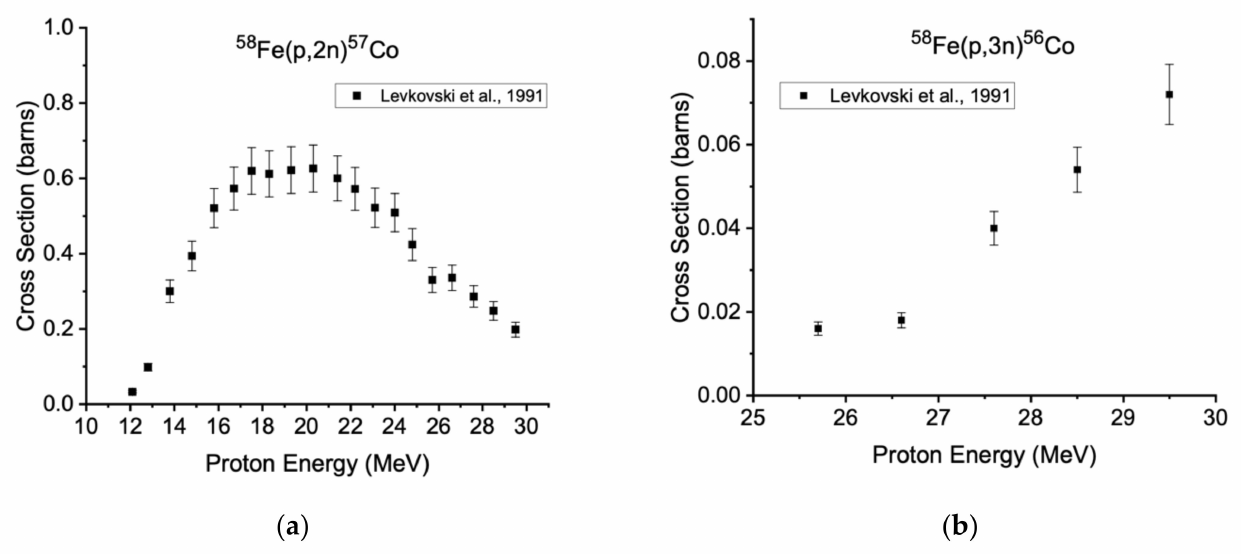
Figure 3. Previously reported excitation functions for ( a ) 58 Fe(p,2n) 57 Co and ( b ) 58 Fe(p,3n) 56 Co, measured using isotopically enriched targets [32].